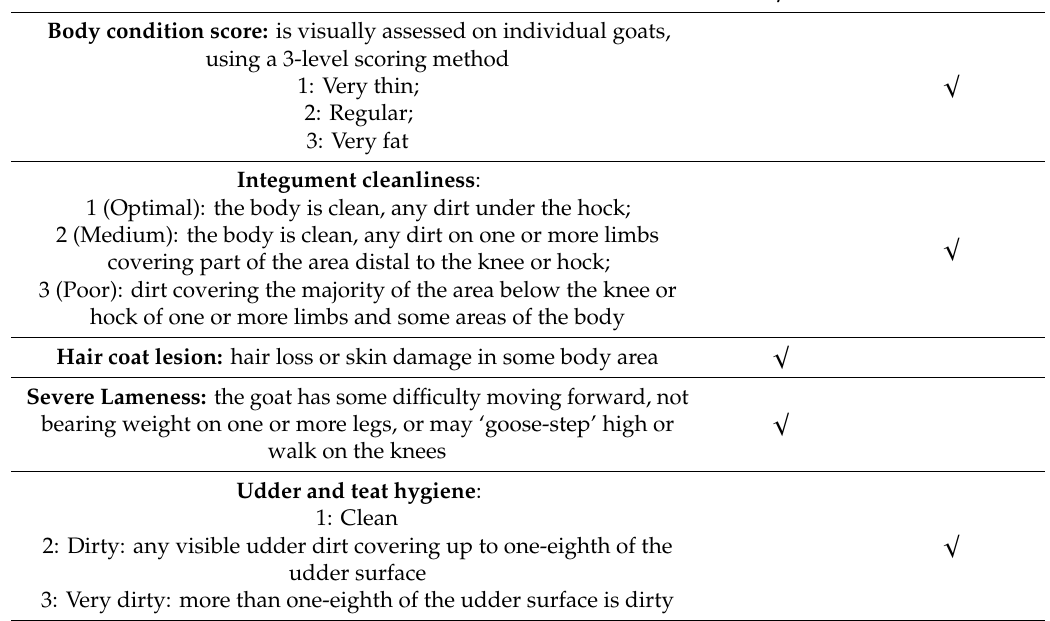
Table A3. Animal-based measures identified by the authors. Animal-based